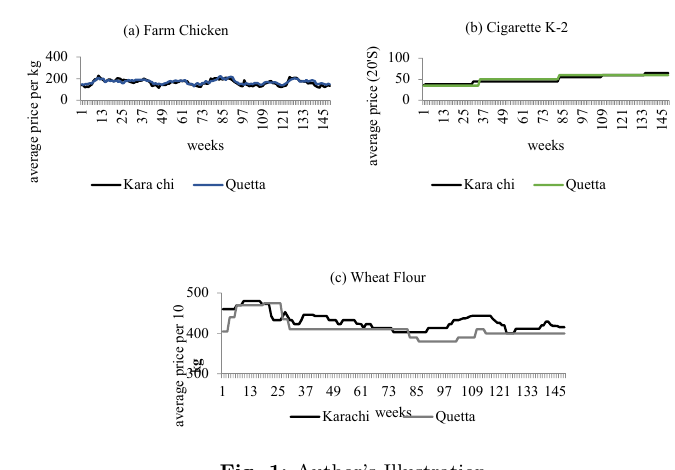
Fig. 1: Author’s Illustration